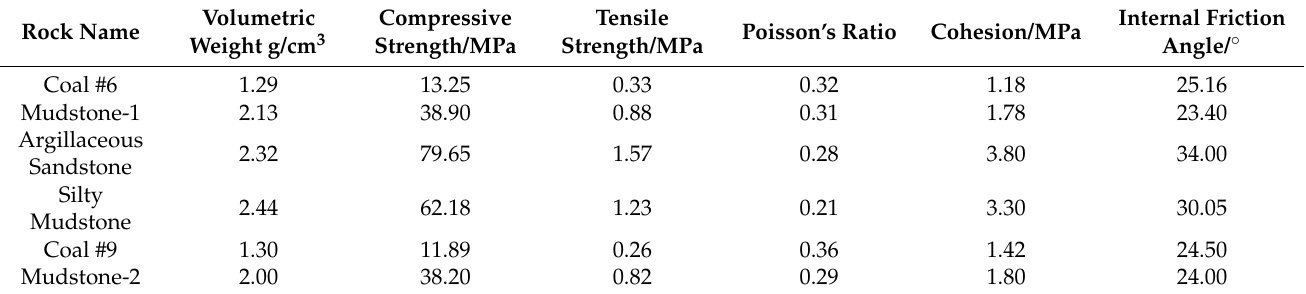
Figure 10. Numerical simulation model. Table 1. Physical and mechanical properties of coal and rock mass.